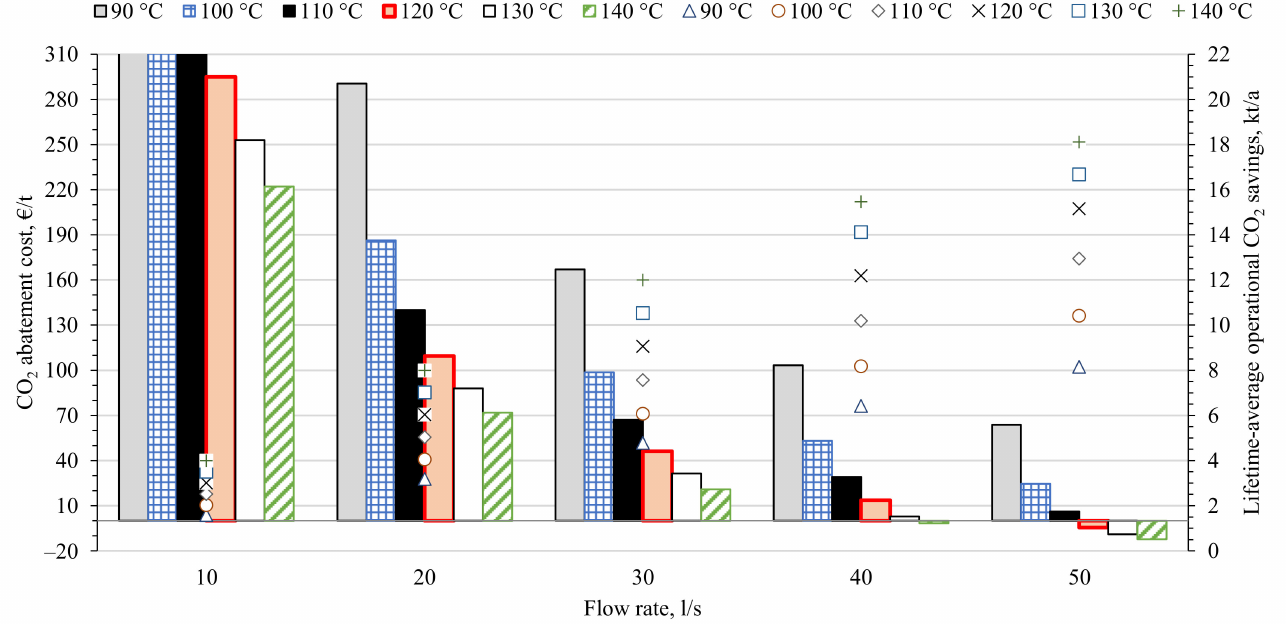
Figure 7. CO 2 abatement cost (columns) and lifetime-average CO 2 operational savings (symbols) for the reference case. Note: the values of CO 2 abatement cost for 90, 100 and 110 ◦ C under 10 l/s are 655, 445 and 355 € /t,